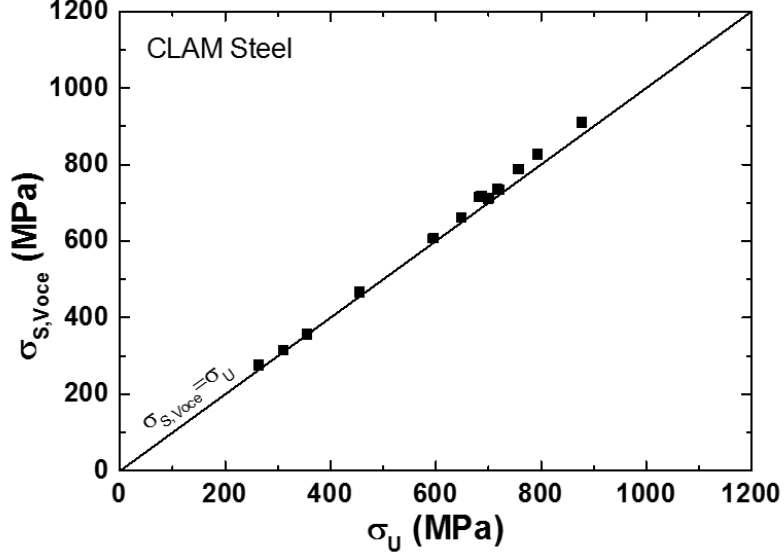
Figure 9. Comparison of saturation stress ( 𝜎 𝑆,𝑉𝑜𝑐𝑒 ) and true ultimate tensile strength ( 𝜎 𝑈 ) at different temperatures in China low activation martensitic (CLAM) steel.